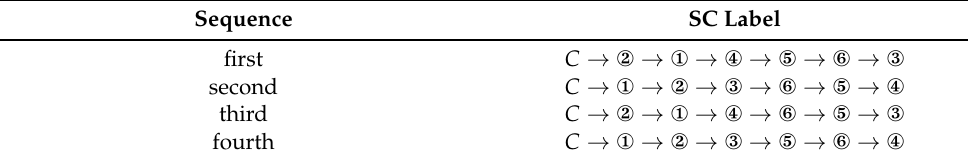
Table 2. Inspection sequences that give a total velocity variation of about 70m/s. Sequence SC Label